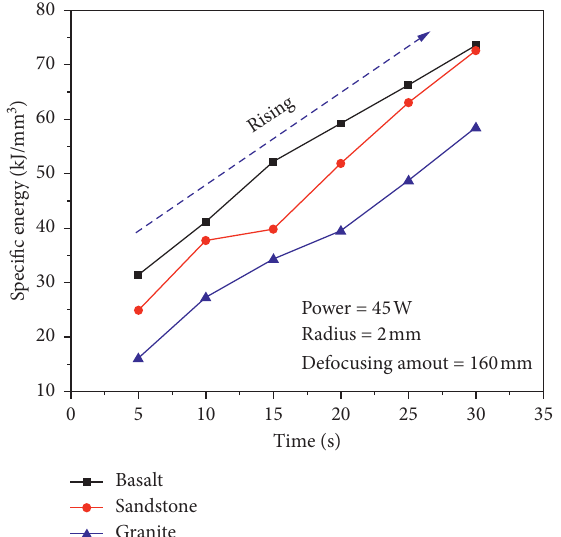
Figure 9: Effect of the laser irradiation time on specific energy (SE) of laser perforating.